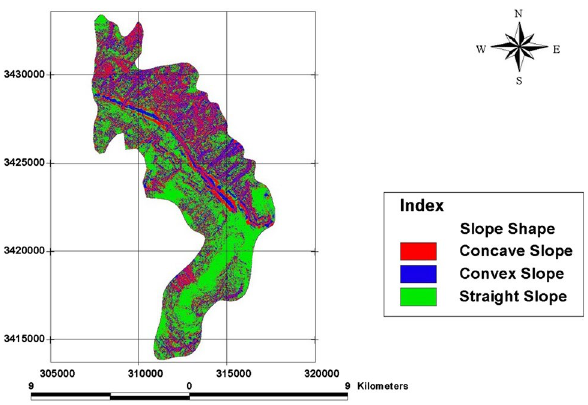
Fig. 9 Slope shape map of the Gangotri glacier